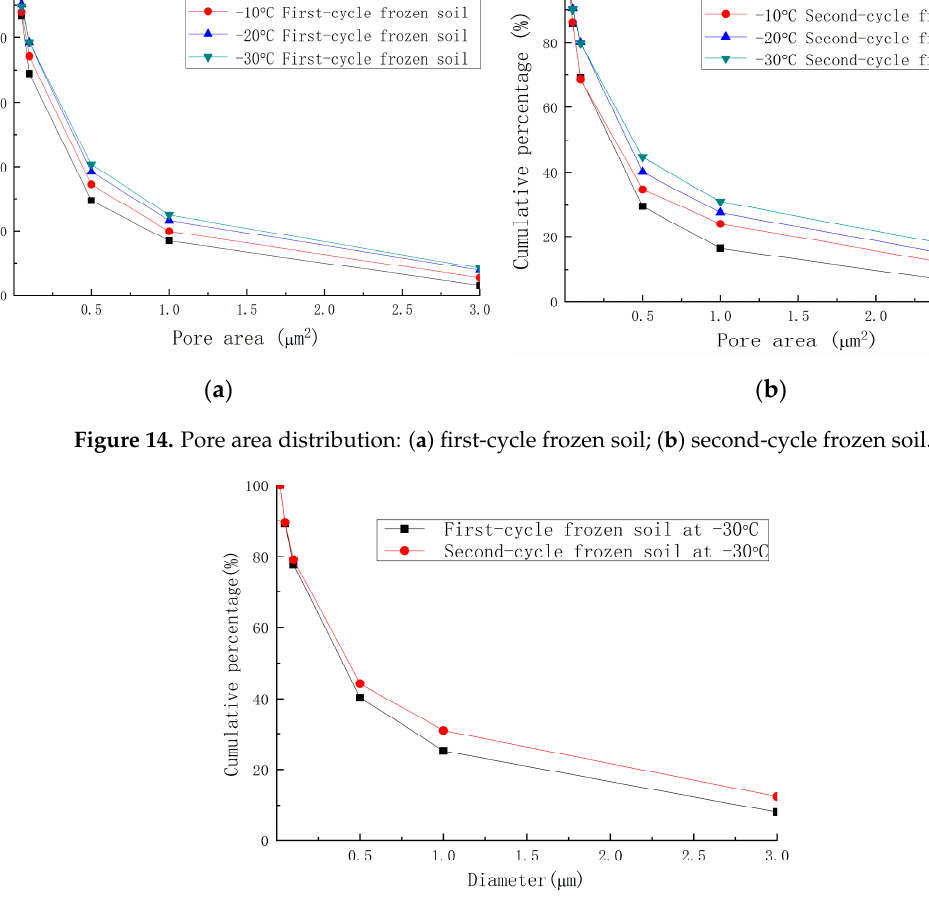
Figure 15. Pore area distribution of frozen soil at − 30 °C.